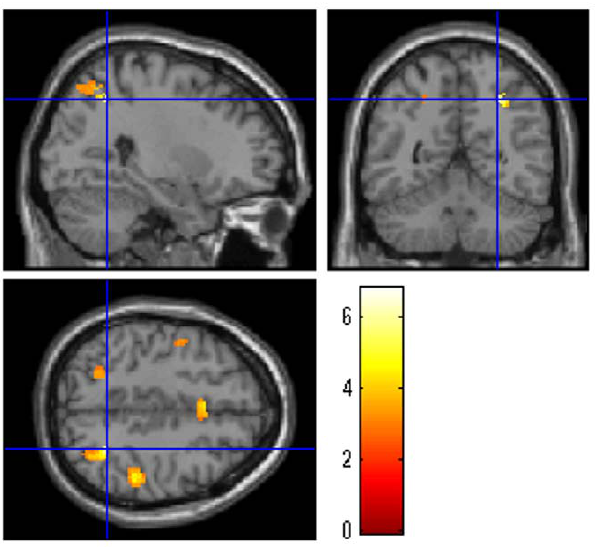
Figure 7. Increases in the functional interaction with the right DLPFC in response to the increases in the WM task speed. Increase in the WM task speed was specifically associated with the increased functional interaction between the right DLPFC (a key node of the WM network) and the right superior parietal lobe. The results are shown with a threshold of P , 0.005, uncorrected for visualization purposes.